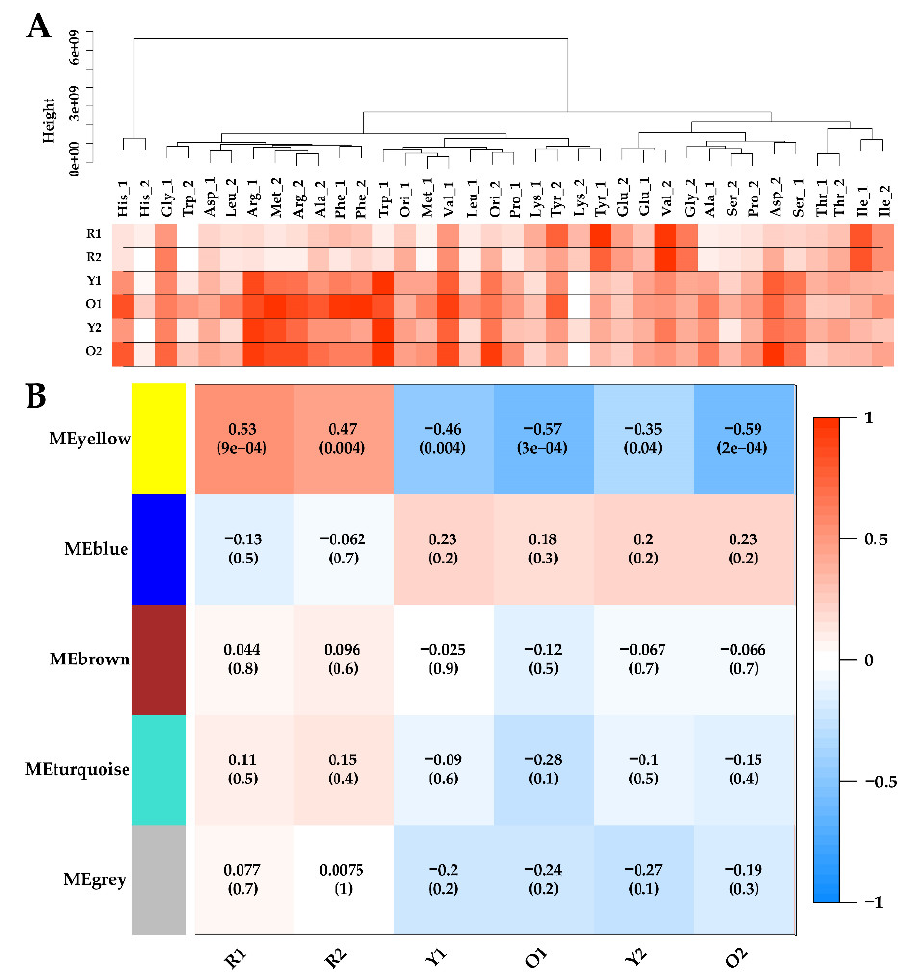
Figure 3. ( A ) Clustering dendrogram of metabolomics samples based on their Euclidean distance, linked to the heatmap of pigment production. The levels of pigment production are proportional to color density. ( B ) Module–trait associations. Each row corresponds to a module eigengene, column to a trait. Each cell contains the corresponding correlation coefficient and p -value.